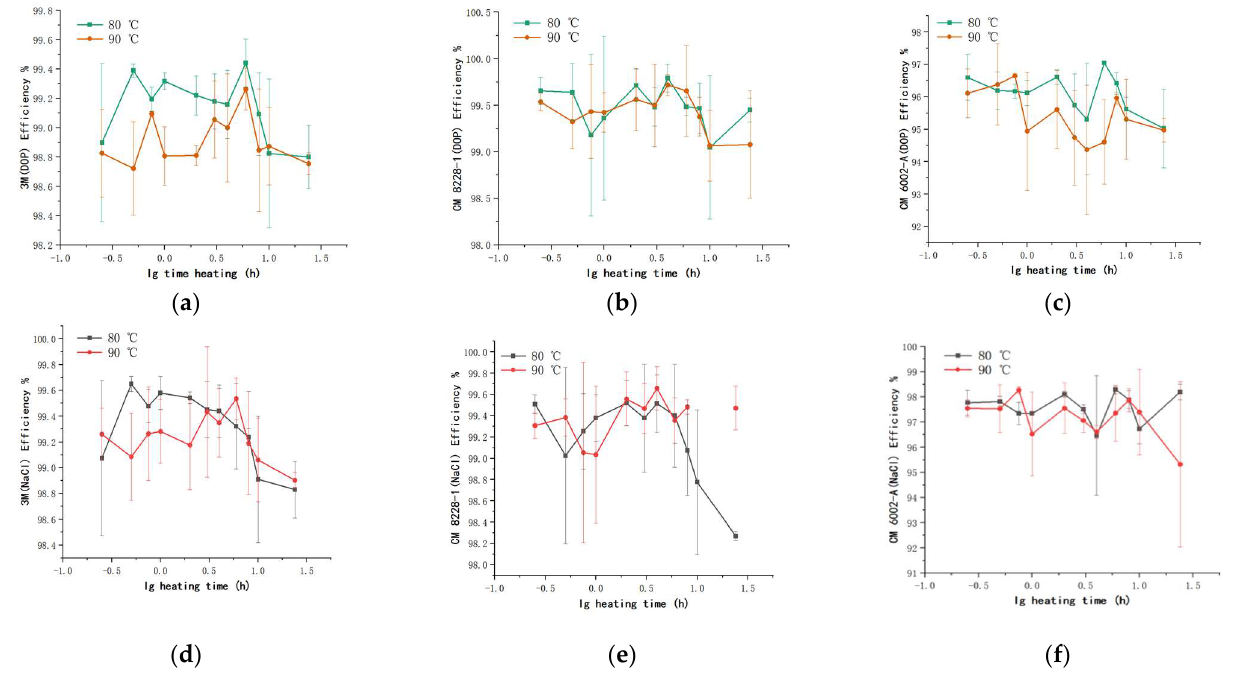
Figure 8. The filtration efficiency of DOP particles through ( a ) 3M KN95, ( b ) CM 8228-1KN95, and ( c ) CM 6002A respirators. The filtration efficiency of NaCl particles through ( d ) 3M KN95, ( e ) CM 8228-1KN95, and ( f ) CM 6002A respirators.